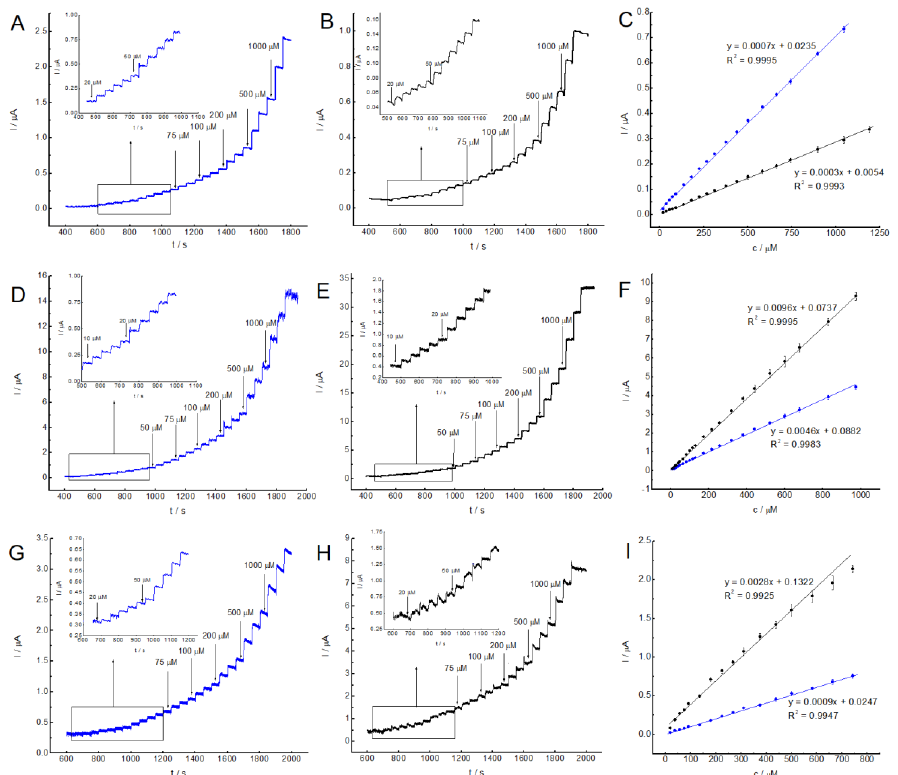
Figure 6. Chronoamperometric analysis of H 2 O 2 determination for ( A ) GC/MWCNTs/ Pz3 , ( B ) GC/MWCNTs, ( D ) GC/SWCNTs/ Pz3 , ( E ) GC/SWCNTs, ( G ) GC/rGO/ Pz3 , and ( H ) GC/rGO electrodes at stirring conditions. The operation potential was +0.6V. ( C – I ) The dependence of the am- perometric current responses on the concentration of hydrogen peroxide for the modified electrodes.